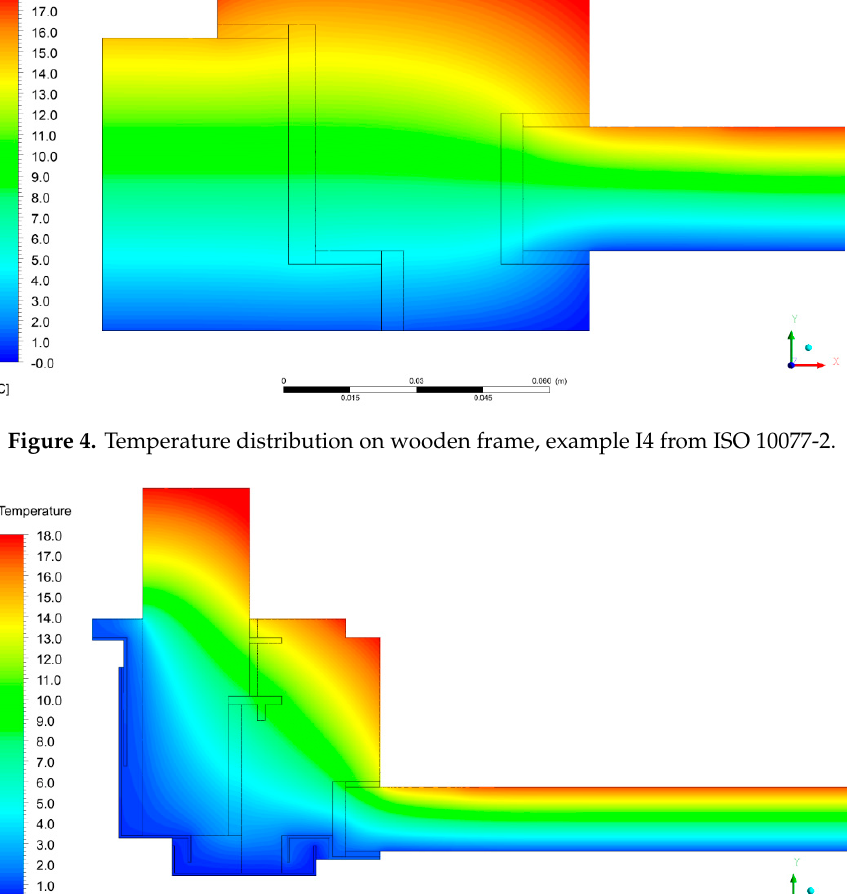
Figure 5. Temperature distribution on roof window frame, example I5 from ISO 10077-2.